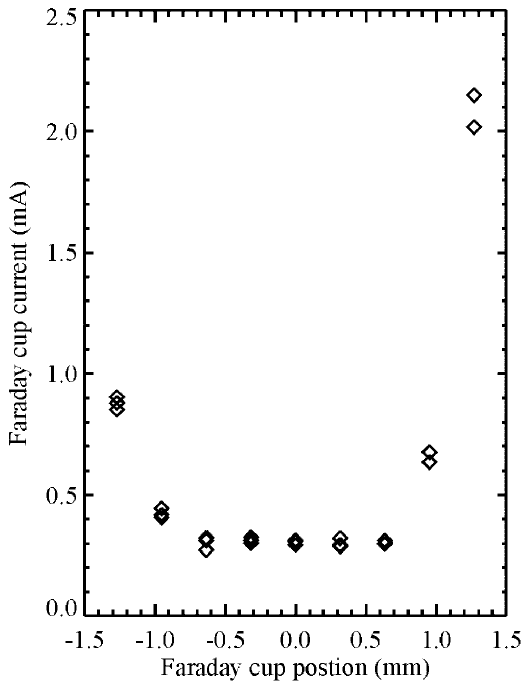
FIG. 6. The beam current measured by the Faraday cup as a function of its position, relative to centered on the entrance aperture.